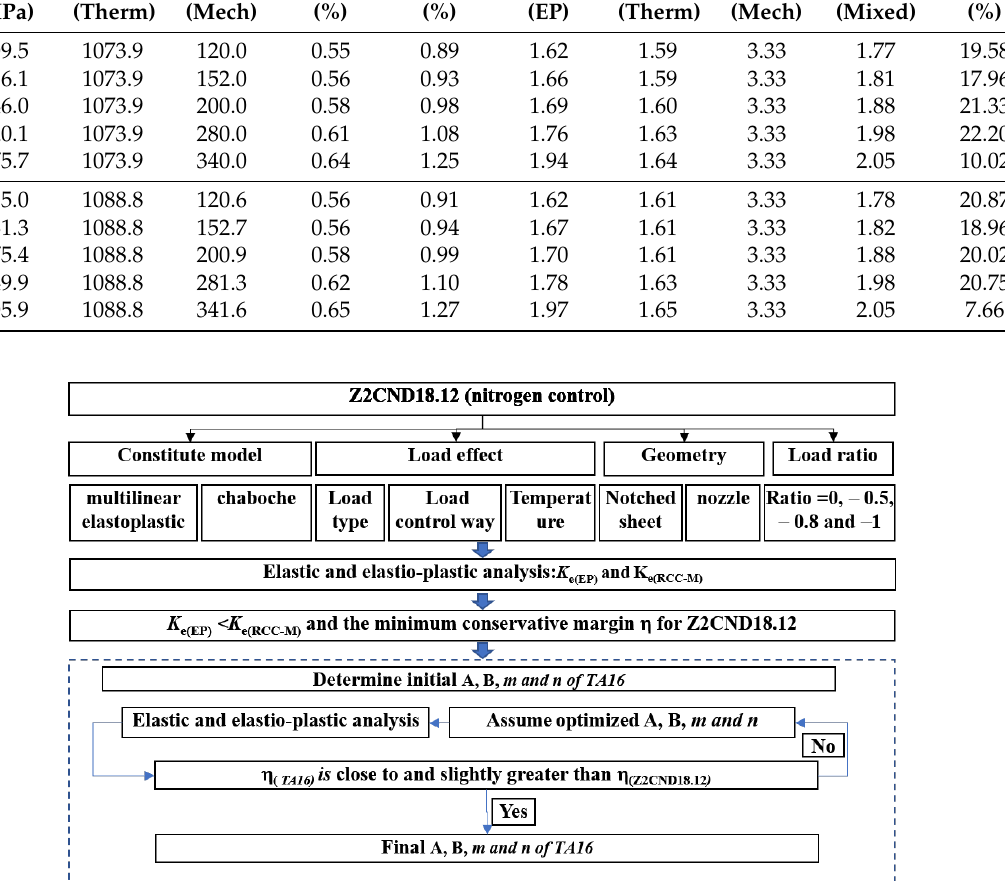
Figure 10. The flowchart of numerical method for determining K e parameters.